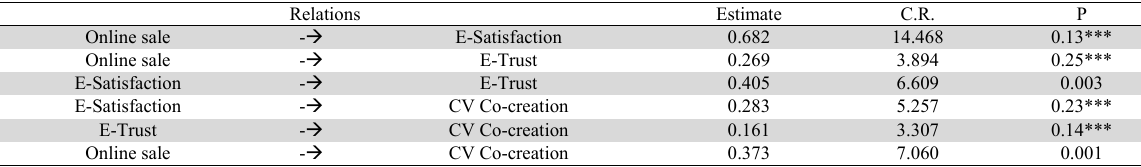
Results of SEM model Relations Estimate C.R.